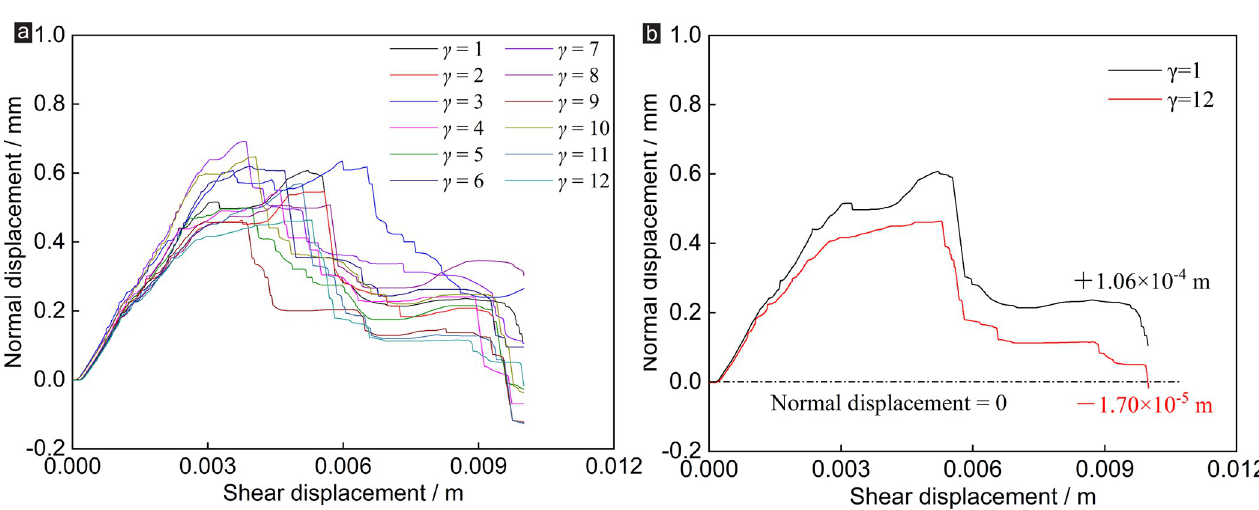
Fig 6. Effect of γ on normal displacement of rock joints under CNS conditions: (a) normal displacement vs. shear displacement, (b) normal displacement vs. shear displacement of γ = 1 and γ = 12.